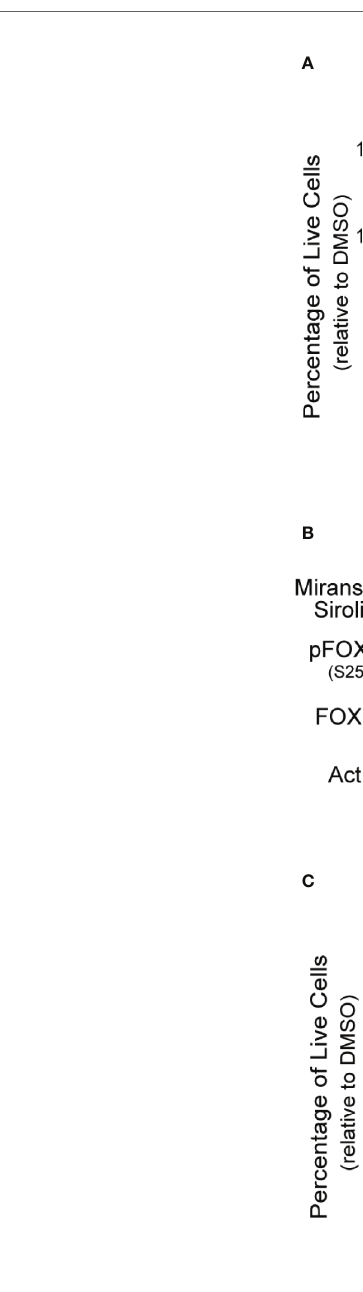
FIGURE 8 | Miransertib and MK-4440 are not toxic to human primary B-cells. (A) Human primary B-cells were treated with DMSO, miransertib (2.5 µM), or MK- 4440 (2.5 µM), and the number of live cells was manually counted by excluding dead cells stained with trypan blue. Every dot represents one of six biological replicates. (B) Primary B-cells were treated for 24 h with DMSO, miransertib (2.5 µM), sirolimus (5 nM), or the combination of both inhibitors. Immunoblots were performed to detect pFOXO1, FOXO1, and the loading control b -actin. (C) Human primary B-cells were treated with DMSO, miransertib (0.31 µM), MK-4440 (0.31 µM) sirolimus (0.13 nM), miransertib (0.31 µM) + sirolimus (0.13 nM), MK-4440 (0.31 µM) + sirolimus (0.13 nM), or dactolisib (6.5 nM), and the number of live cells were manually counted by excluding dead cells stained with trypan